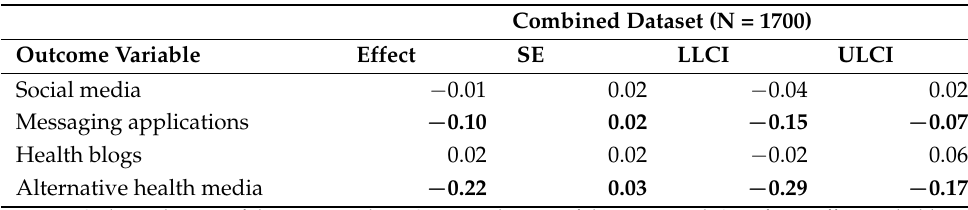
Table A9. The mediation effect of media reliance for COVID-19 news on vaccination behavior (adding “reliance on health organizations”)..